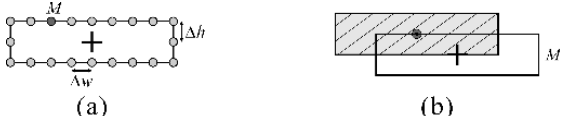
Figure 7. Schematic diagram of selecting the candidate label positions. ( a ) Reference points for distance computation; ( b ) generated candidate label position for reference point M .